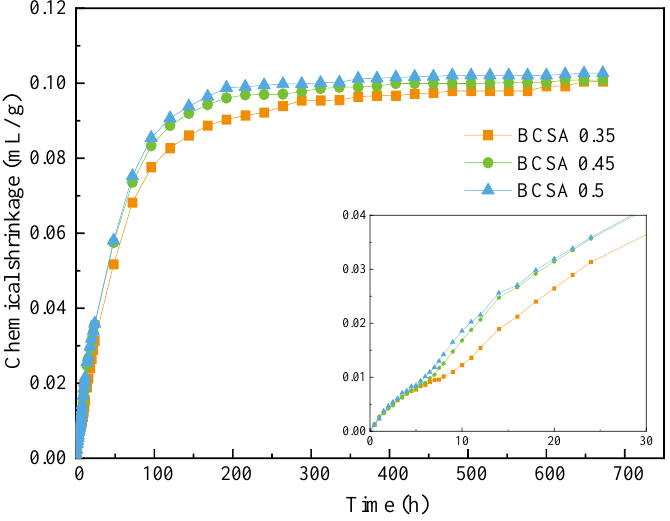
Figure 4. Chemical shrinkage of BCSA pastes with different w / c ratios.